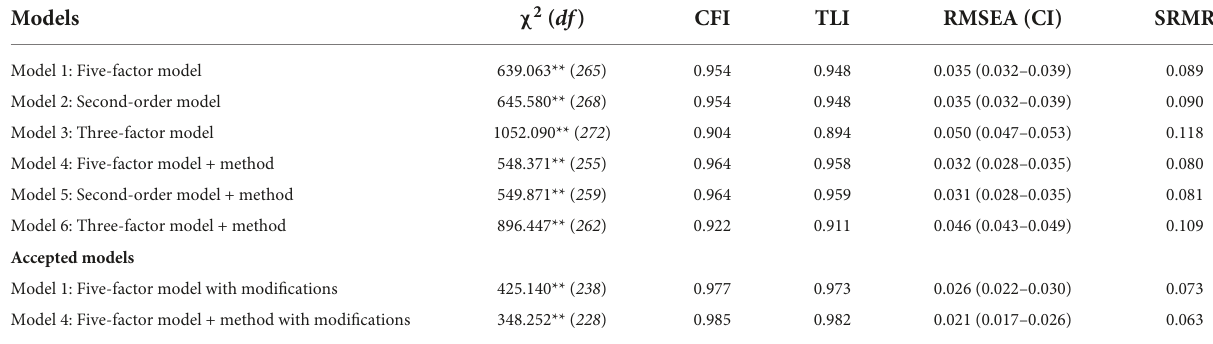
TABLE 2 Model fit indices for the confirmatory factor analysis of the six tested models of the Strength and Difficulties Questionnaire (SDQ) structure ( n = 1142).